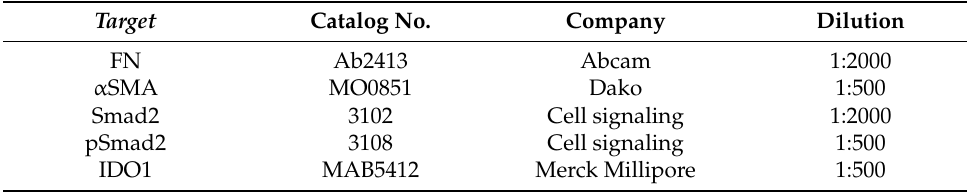
Table 2. Primary antibodies used for western